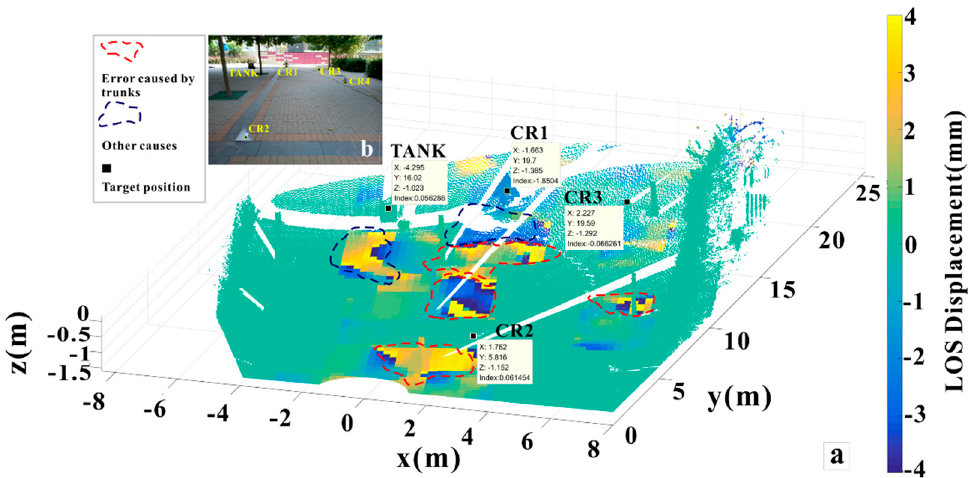
Figure 11. ( a ) Mapped 3D displacement map obtained at 16:42 GMT+8 colored by displacement value (in mm labeled as “index”) and the abnormal values were circled out; ( b ) Corresponding image of the scenario.